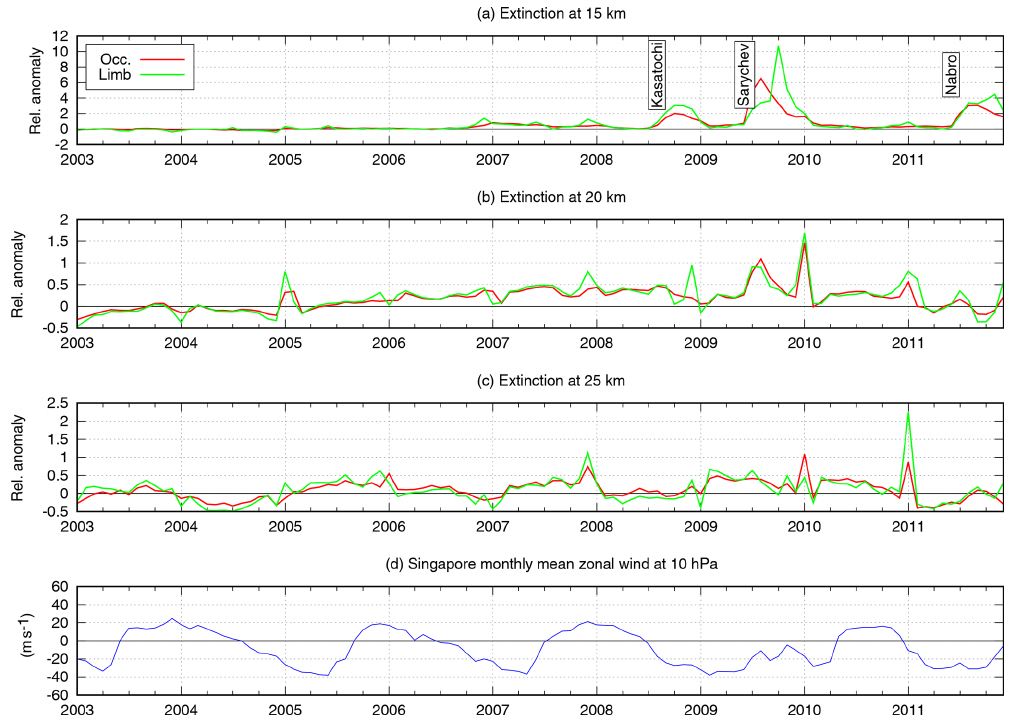
Figure 16. Time series of relative aerosol extinction anomalies at 750nm for altitudes 15, 20 and 25km and Singapore monthly mean zonal wind at 10hPa (a–d) . Red: SCIAMACHY solar occultation data. Green: SCIAMACHY limb data. Blue: zonal wind (as proxy for